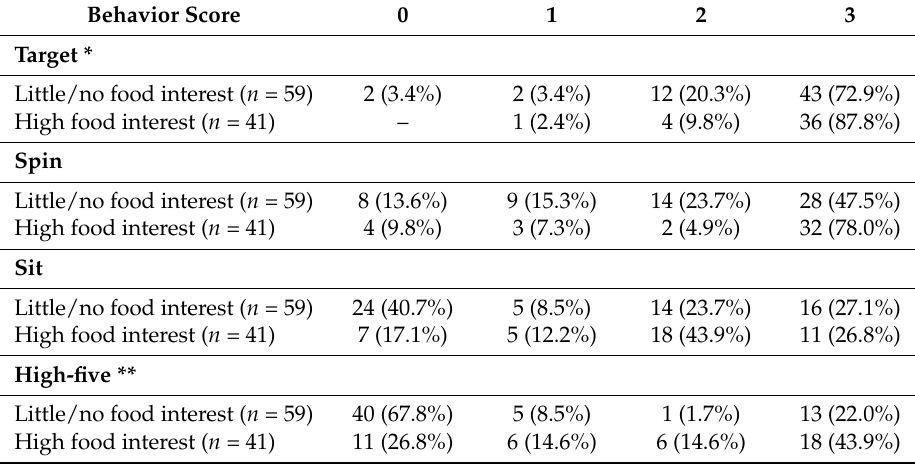
Table 4. Post-assessment median behavior scores and relation to food